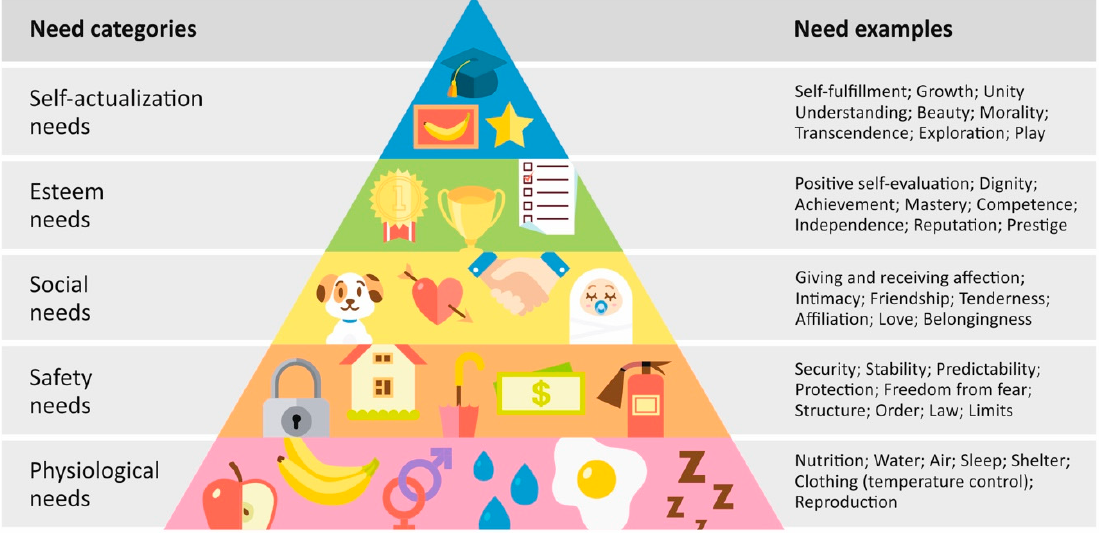
Figure 1. Pyramid representation of Maslow’s Hierarchy of Needs (image based on [31]). Even though the popularity of Maslow’s theory is partly attributed to the iconic appeal of the pyramid (or, more accurately, the triangle), Maslow himself never used the triangle image. In a recent paper, Bridgman, Cummings, and Ballard [34] traced the origins of the triangle visualisation to a manuscript of the consulting psychologist Charles McDermid [35]. After that, the image was popularized by management textbooks. Table 1. The five need categories in Maslow’s Hierarchy of